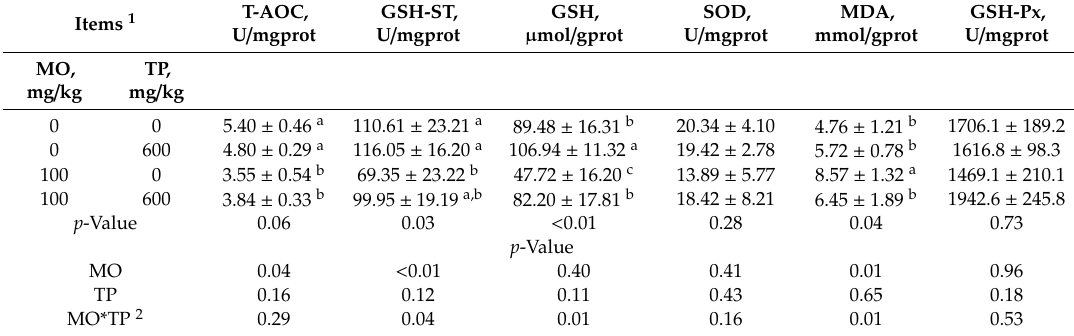
1 Each mean represents 5 cages, with 2 layer / cage. Abbreviations represented: TP = tea polyphenols; MO = molybdenum; T-AOC = total antioxidant capacity; GSH-ST = glutathione s-transferase; GSH = glutathione; SOD = superoxide dismutase; MDA = malonaldehyde; GSH-Px = glutathione peroxidase. 2 MO*TP means the interaction between MO and TP. a,b Means in the same column with di ff erent letters di ff er significantly ( p <